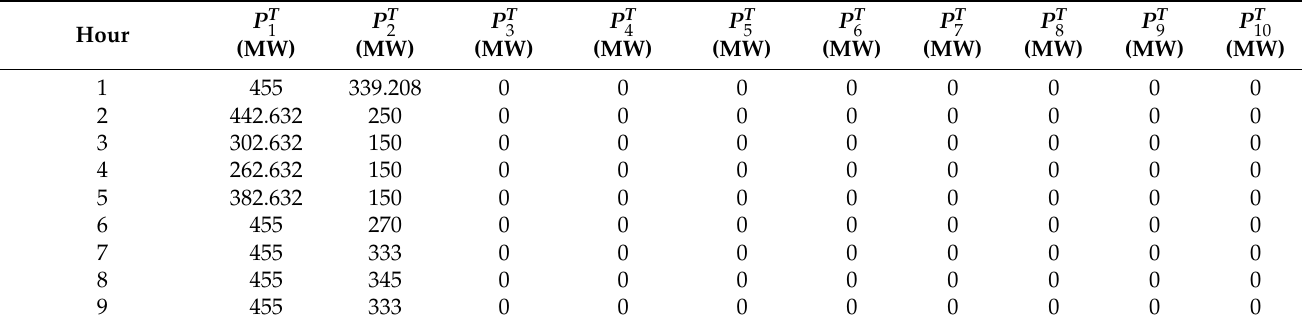
Table A2. Optimal operation scheduling for the conventional thermal units in case